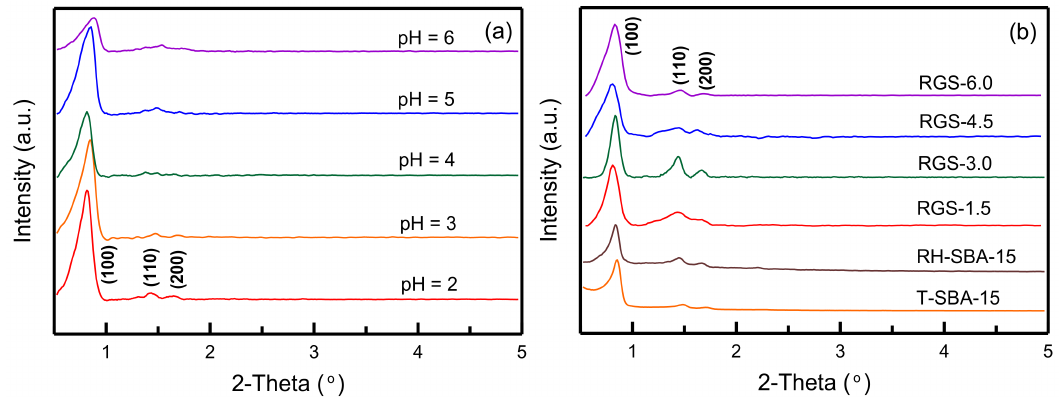
Figure 1. XRD patterns with low-angle diffraction of RH-GO/SBA-15: ( a ) different gelation pH values, and ( b ) different amounts of GO suspension.